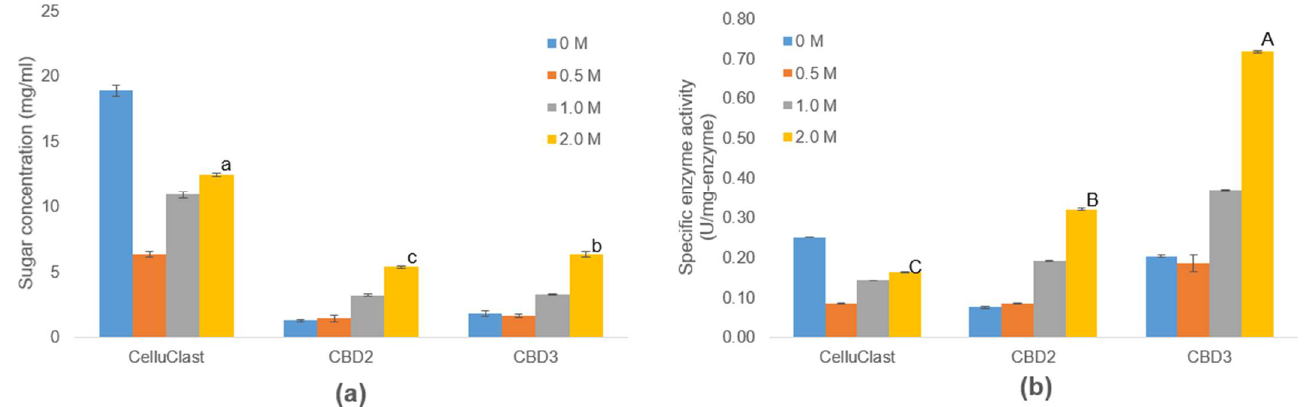
Figure 7. ( a ) The sugar concentrations produced from one-pot process and ( b ) specific enzyme activities of bacterial cellulase (CBD2 and CBD3) and commercial cellulase (Celluclast 1.5 L). The represented data are the mean of three replicates ± standard error ( p ≤ 0.05). a, b, c determine statistically difference in sugar concentrations. A, B, C determine statistically difference in specific enzyme activity.